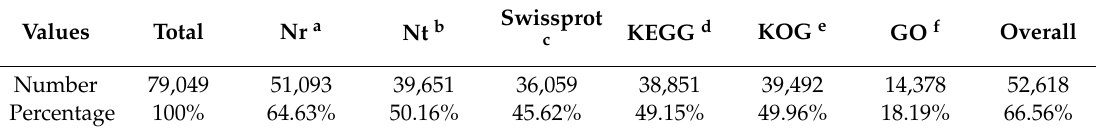
Table 1. The annotation of assembled Unigenes.